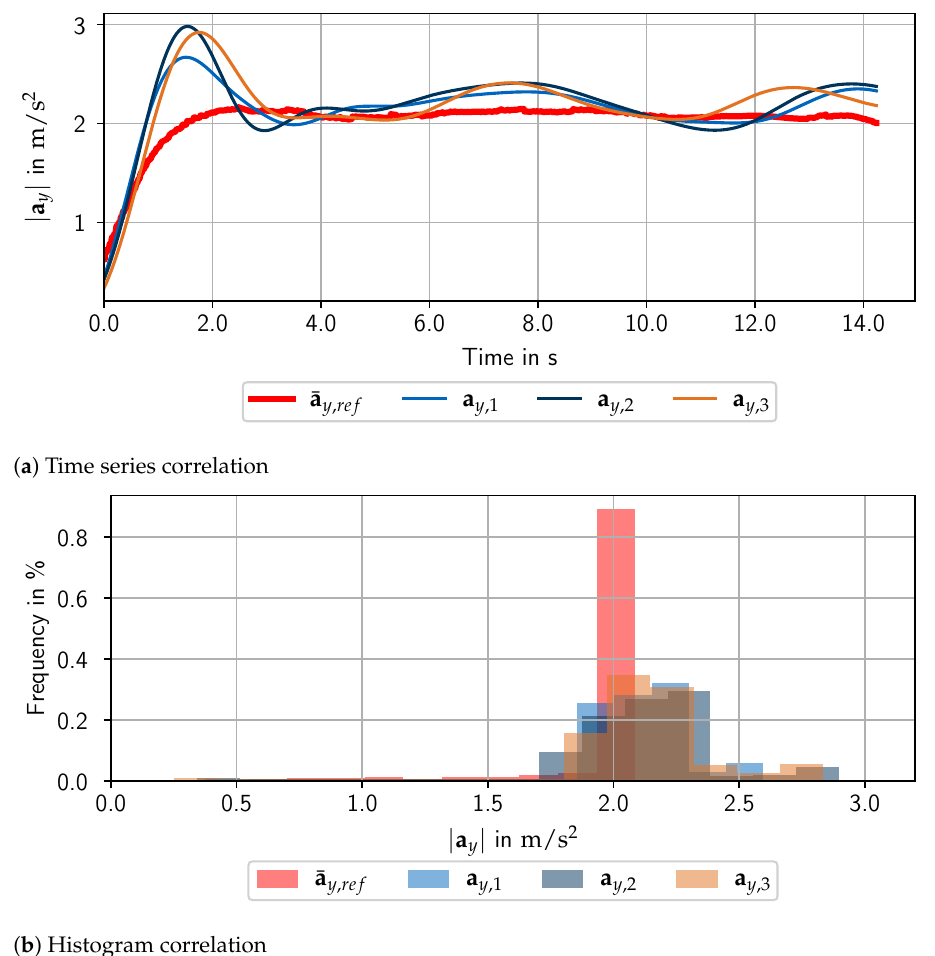
Figure 8. Correlation analysis with ( a ) time series and ( b ) derived histogram data (15 bins). On the one hand, both subplots contain the lateral acceleration signals a y of three repetitions. On the other hand, they contain the averaged reference lateral acceleration signal ¯ a y , ref , as the three repetitions almost coincide. The peaks at the beginning of the signals are caused by the transient passage between the straight line and the curve entrance at the validation scenario v x = 118km/h and a y , ref = 0.85 a y , smax ·